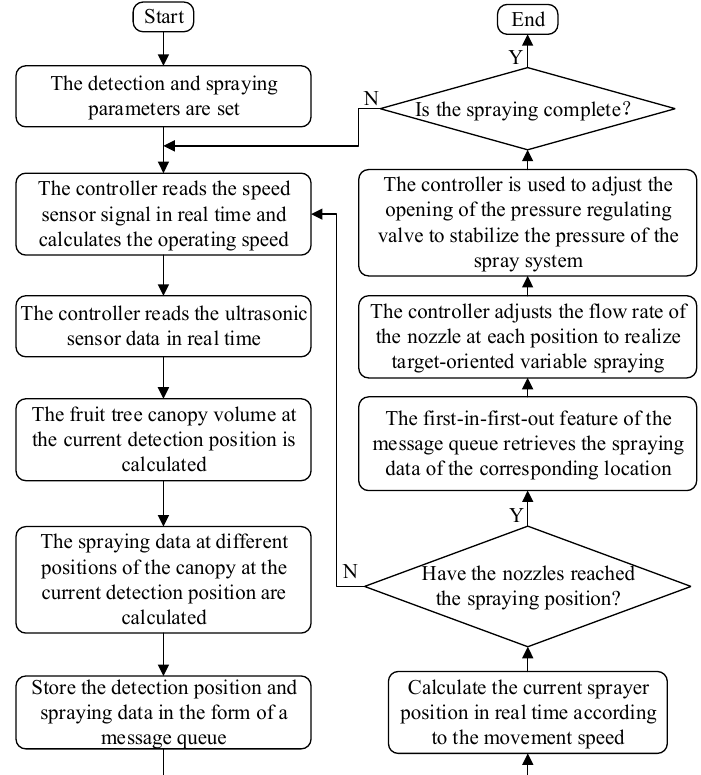
Figure 4. Flow chart of target-oriented variable spraying.